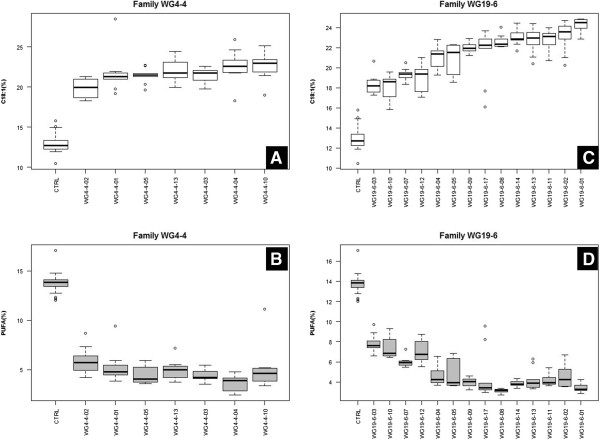
Boxplots of C18:1 (A and C) and PUFA (B and D) levels in the seeds of T2 plants of C. abyssinica. Each box indicates a T2 plant; ten single seeds per plant were measured.